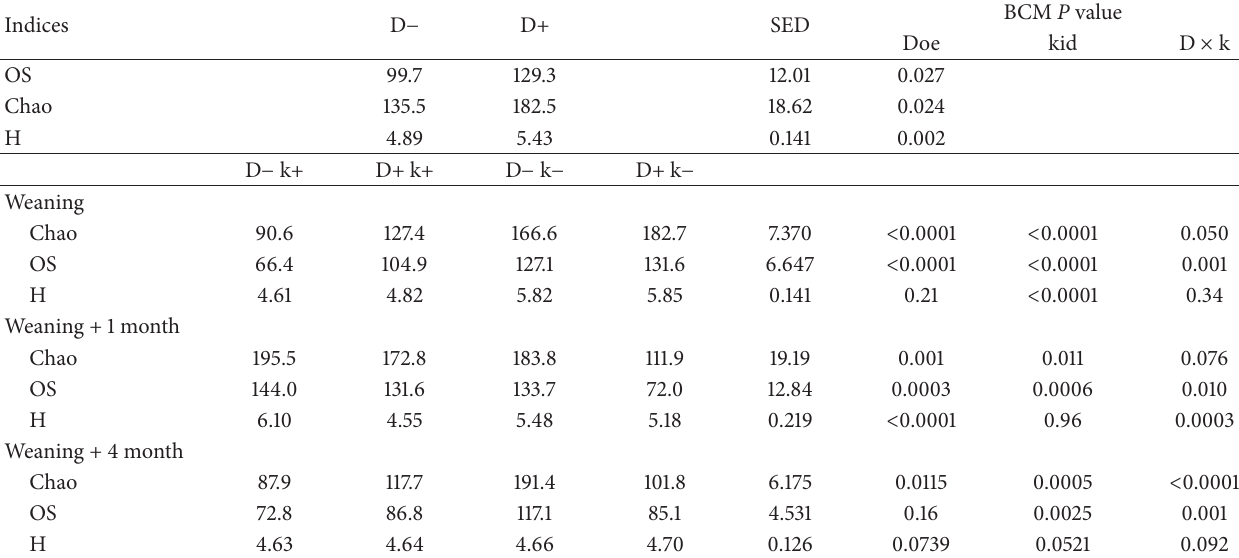
Table 3: Effect of bromochloromethane (BCM) treatment of does and kids on diversity (Chao; observed species, OS; and Shannon, H) of the rumen archaeal community in does at weaning and kids at weaning, 1 month, and 4 months later.